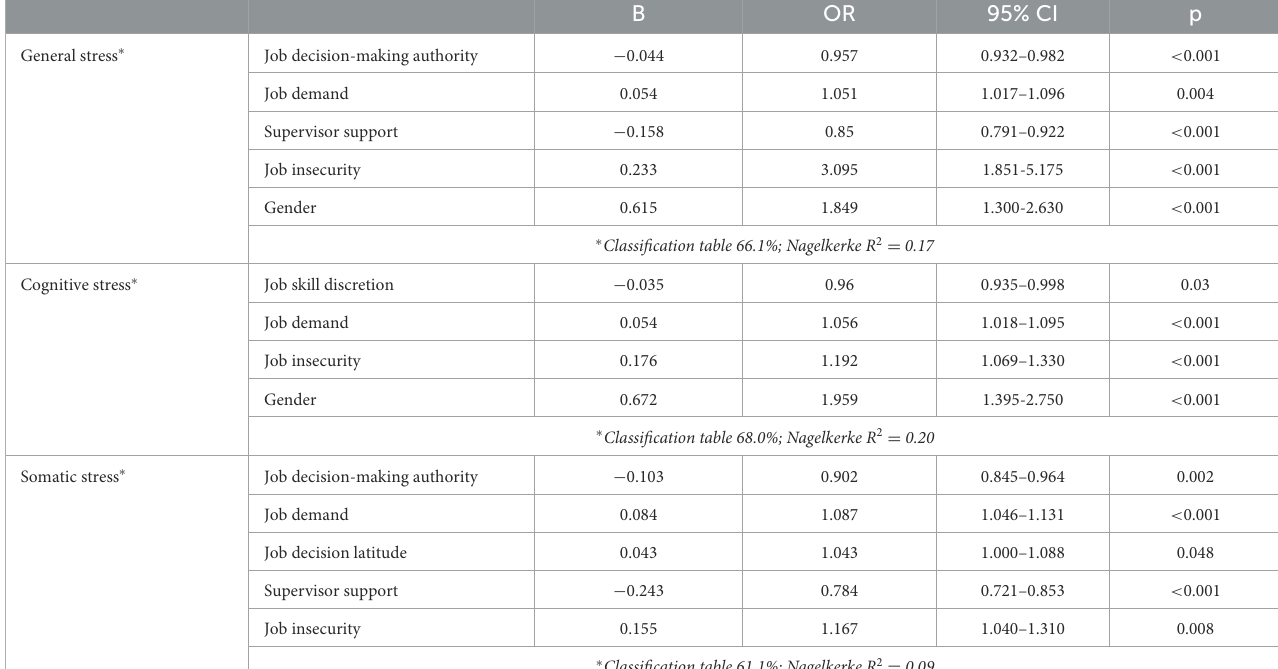
∗ Classification table 61.1%; Nagelkerke R 2 =